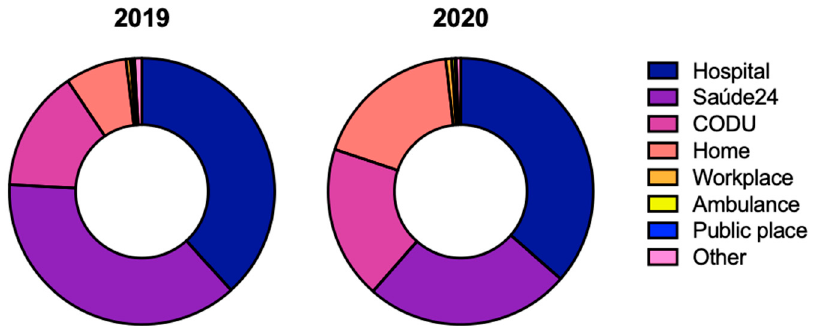
Figure 2. Characterization of the place of origin of the call to the Poison Information Centre in the Algarve region in 2019 and 2020. Comparing 2019 and 2020, the distributions were as follows: hospital (38.29% vs. 36.41%), saúde24 (37.52% vs. 25.07%), CODU (14.75% vs. 18.63%), home (7.50% vs. 18.07%), workplace (0.52% vs. 0.70%), ambulance (0.26% vs. 0.42%), public place (0.26% vs. 0.14%), other (0.91% vs. 0.56%). Saúde24 (SNS24) is a healthcare hotline, i.e., a telephone and online service